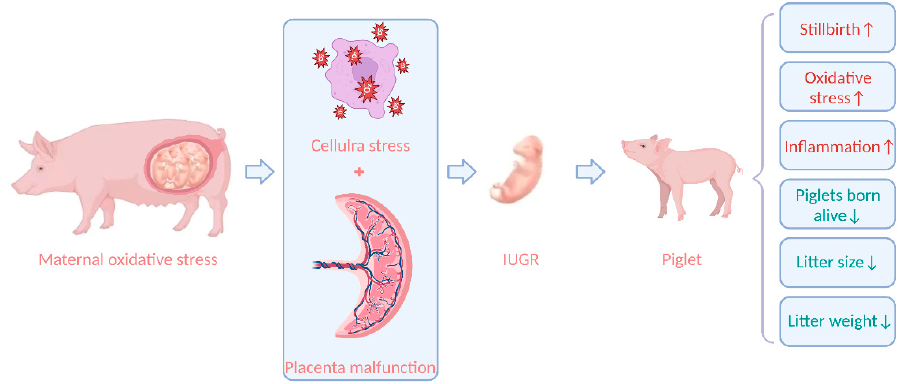
Figure 1. The effect of oxidative stress on the fetus. IUGR, intrauterine growth retardation. Figure 1 created with BioRender.com URL (https://app.biorender.com/).